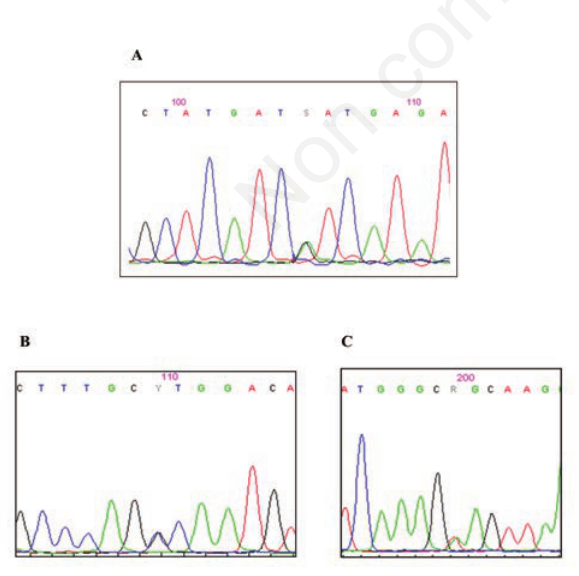
Figure 2. TF S208S polymorphism Dde I restriction fragments. Lanes 1 and 14: ϕ X174 Hae III; lane 2 negative control; lanes 4, 5, 7, 8 and 12: negative samples; lanes 3, 6, 9, 11 and 13: het- erozygous samples; lane 10: homozygous